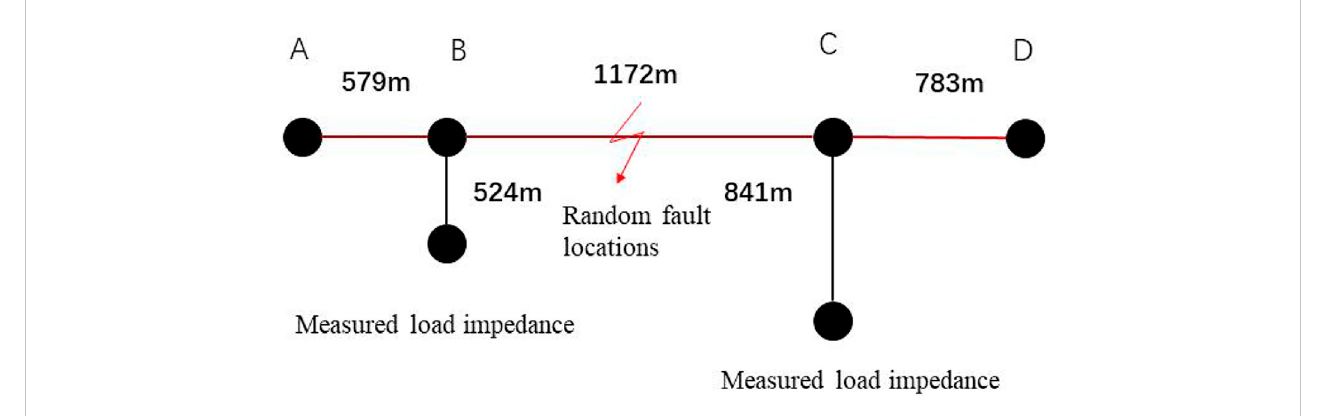
FIGURE 9 Topological network structure diagram.